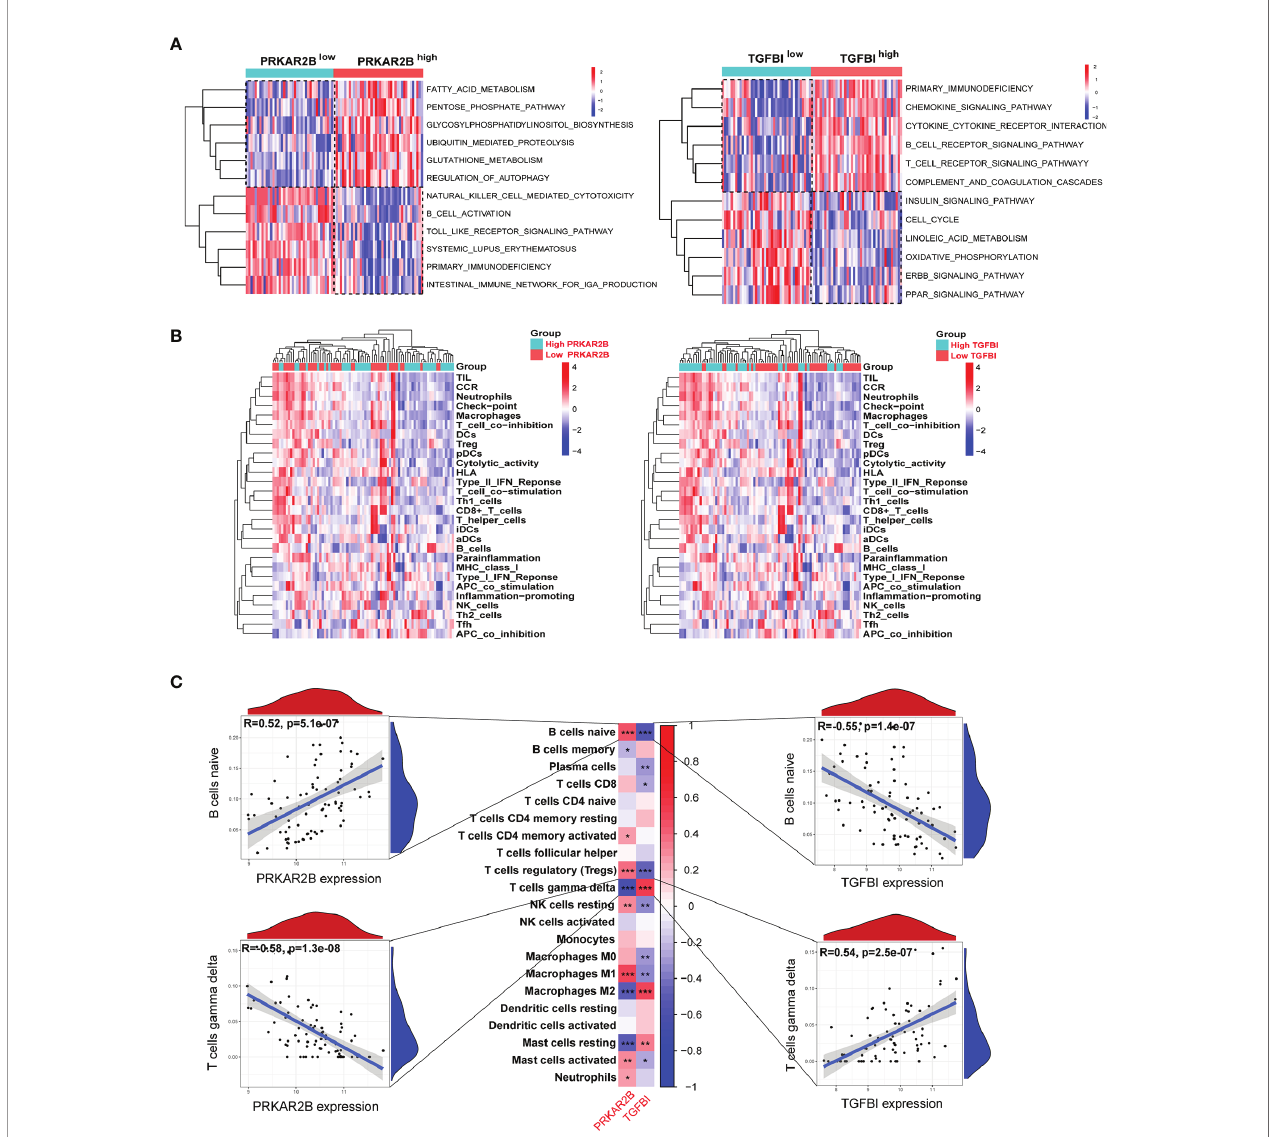
FIGURE 7 | The association between the biomarkers and immune in fi ltration in the GDN samples. (A) Heatmap of metabolism and immune-related gene sets by GSVA. (B) Heatmap of the immune landscape by ssGSEA. (C) Heatmap of the correlations between the biomarkers and in fi ltrating immune cells. *** p < 0.001; ** p < 0.01; * p <